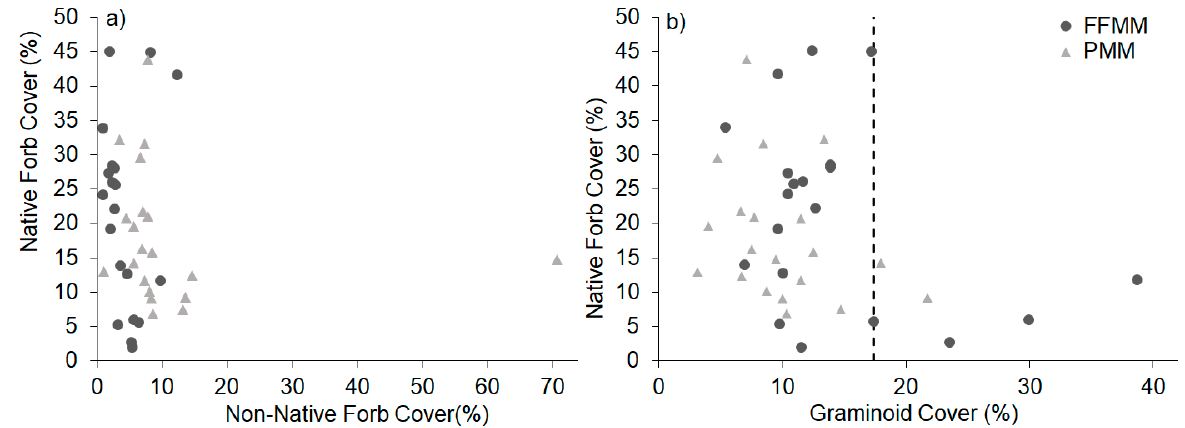
Figure 2. Scatter plot between native forb cover (%), ( a ) non-native forbs, and ( b ) graminoid cover (%) with a threshold created from a regression tree analysis (threshold for graminoid cover ≥ 17.4% n = 6, <17.4% n = 34).